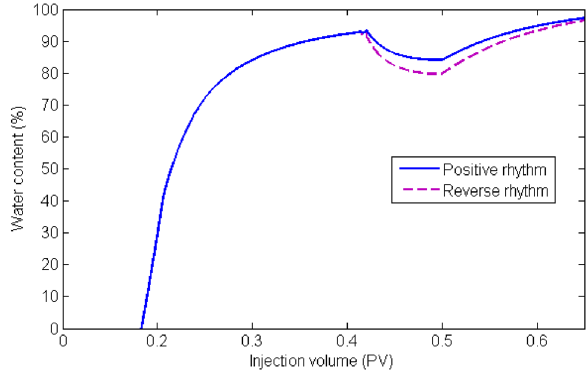
Fig. 6 Comparison of oilfield testing data and the presented model